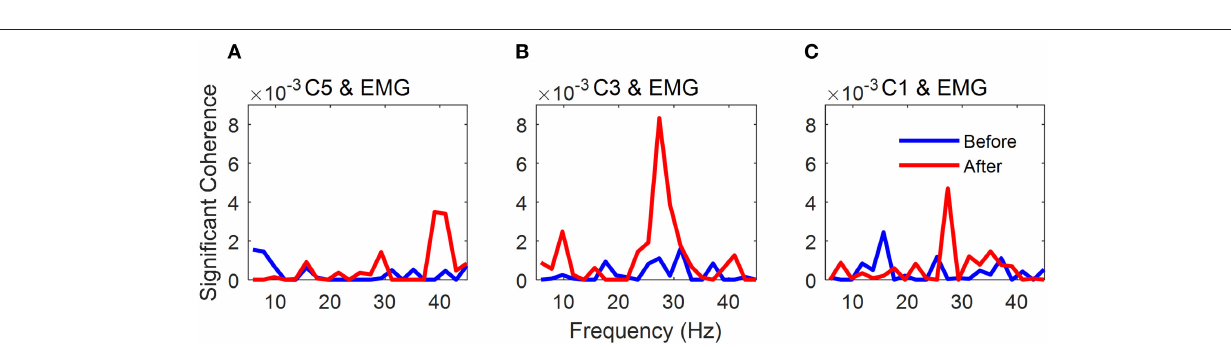
FIGURE 4 | Grand average of significant EEG-EMG coherence. (A) C5 EEG-EMG coherence. (B) C3 EEG-EMG coherence. (C) C1 EEG-EMG coherence. The blue line indicates significant coherence before NMES, while the red line indicates significant coherence after